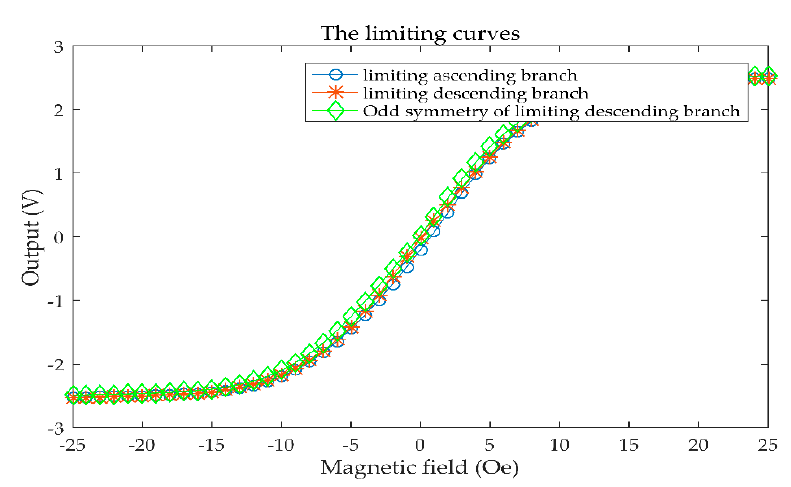
Figure 6. The limiting curves.